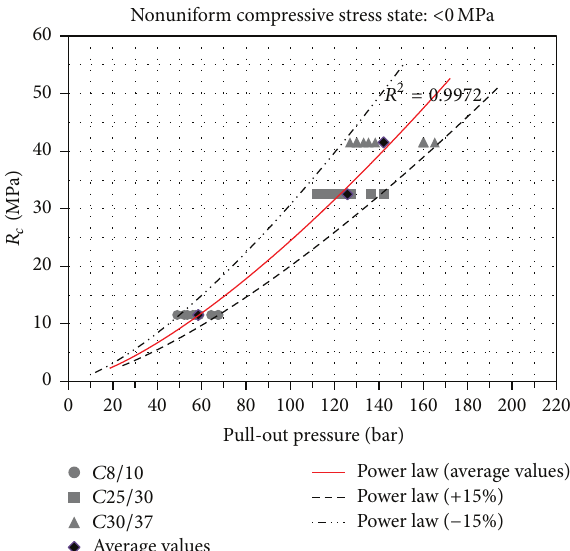
Figure 17: Comparison of the calibration